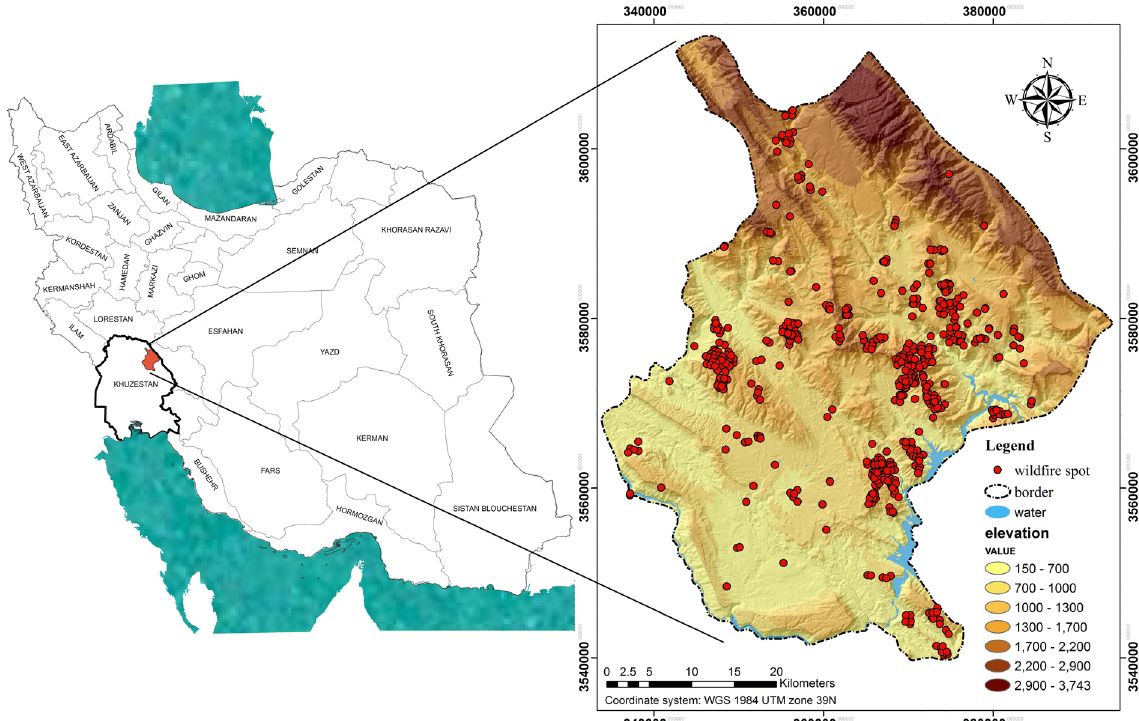
Figure 1. Location of Andika region and VIIRS fire spots